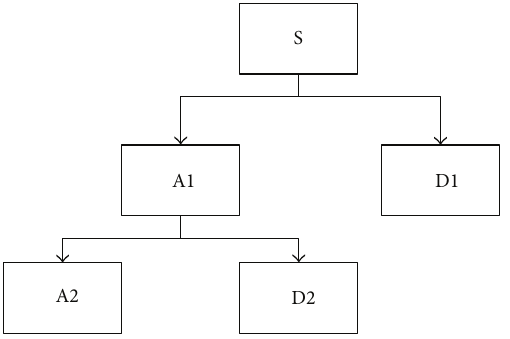
Figure 1: Wavelet